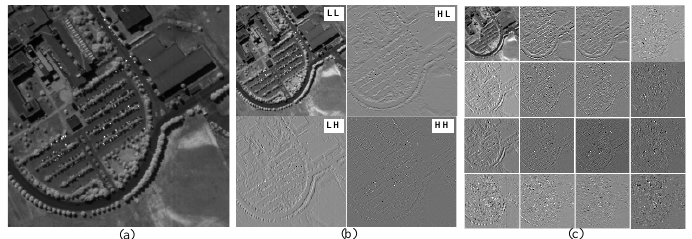
Figure 1. An example of wavelet package transformation (WPT) of different levels: ( a ) the original image, cropped from the 100th band of Pavia University data, ( b ) one-level decomposition, ( c ) two- level